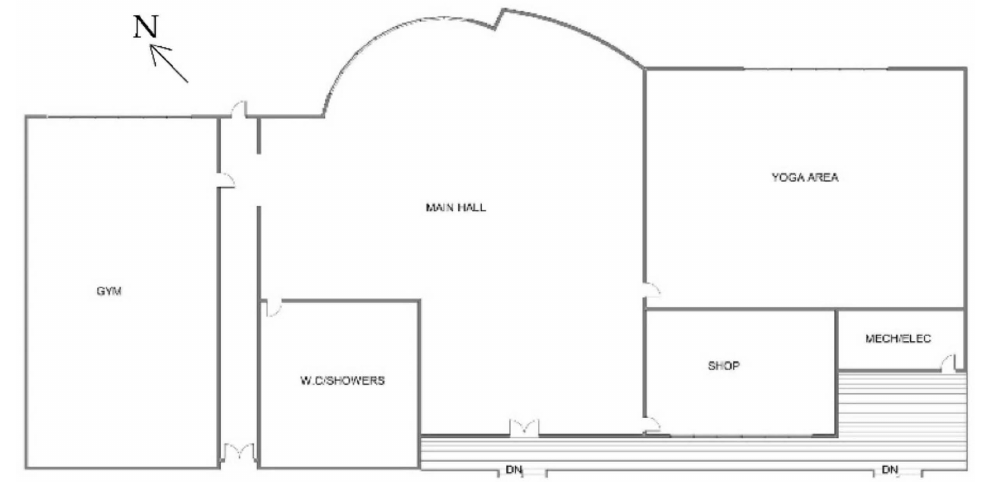
Figure 9. Base model floor plan; occupancy schedule.